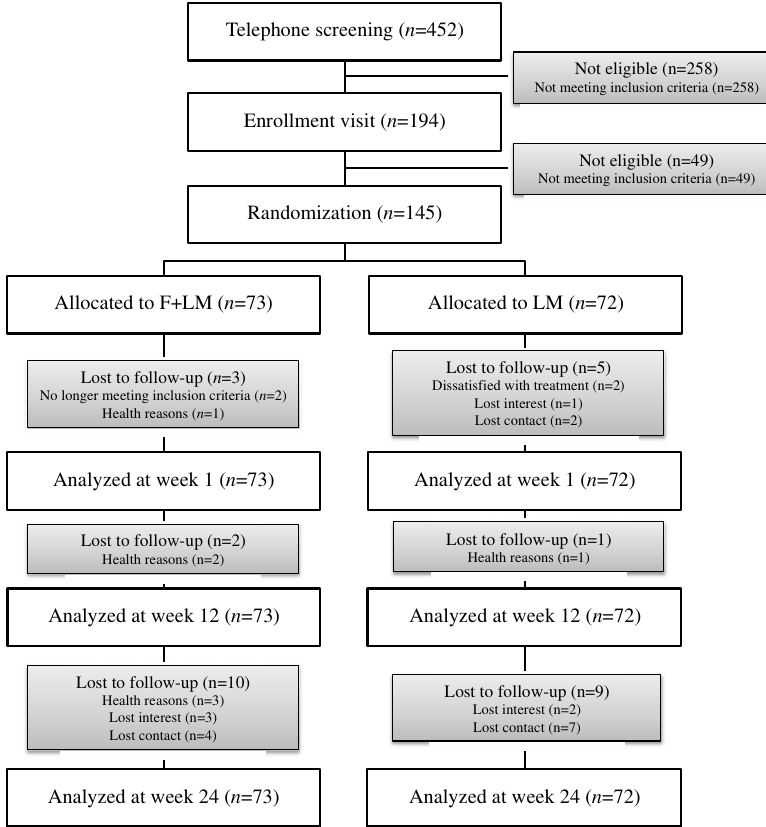
Figure 1. Study flow chart. F + LM, fasting and lifestyle modification; LM, lifestyle modification. Patients were recruited between April 2014 (first patient in) and December 2014. The last follow-up assessment was completed in December 2015 (last patient out). pants were female and about one third had a university degree (mean age 59.7 ± 9.3 years). Participants had a BMI of 33.3 ± 4.5 kg/m 2 . Participants in the F + LM group attended a mean of 8.2 ± 2.3 (82%) out of 10 possible intervention sessions; those in the LM group attended 7.1 ± 3.5 (71%) sessions ( p =